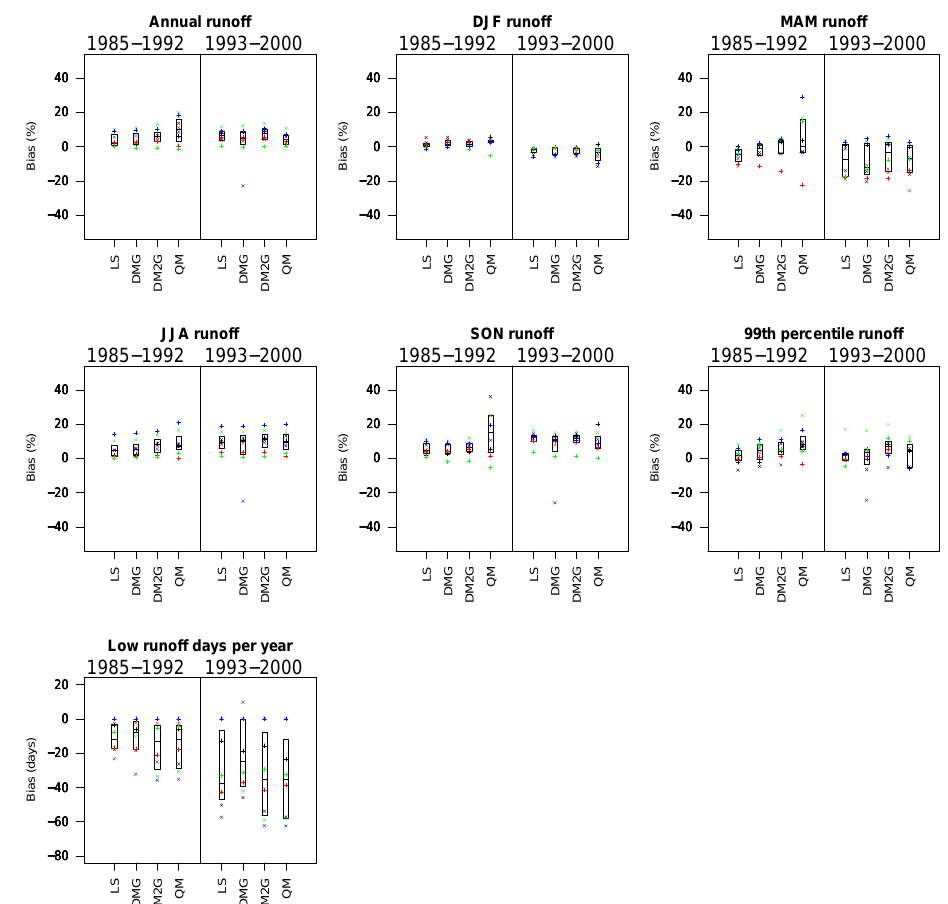
Figure 9. As for Fig. 7, but showing runoff characteristics modelled by GR4J.